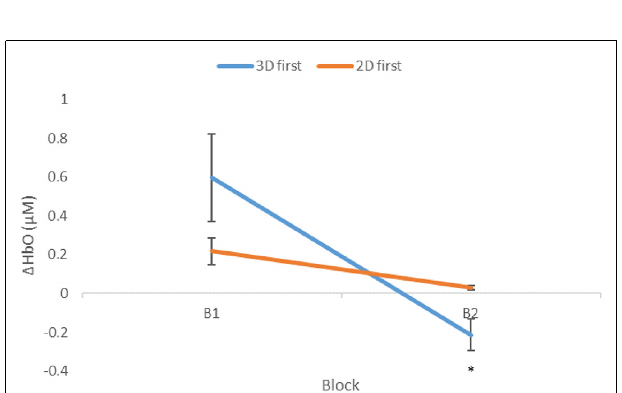
FIGURE 5 | Mean ∆ HbO ( µ M) as a function of presentation order. Condition changes from first (B1) to second (B2) block. Significantly lower mean ∆ HbO was seen in B2 with respect to B1 for participants that initially performed the 3D condition, p = 0.0015, shown as 3D first (3D/B1 group). Error bars show standard error values. ∗ denotes statistical